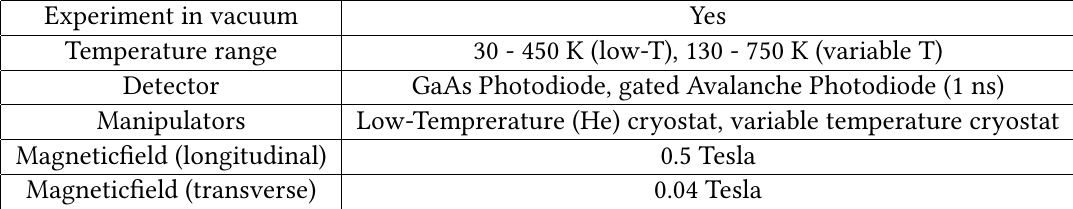
Table 3: Technical parameters of the FEMTOSPEX transmission station.